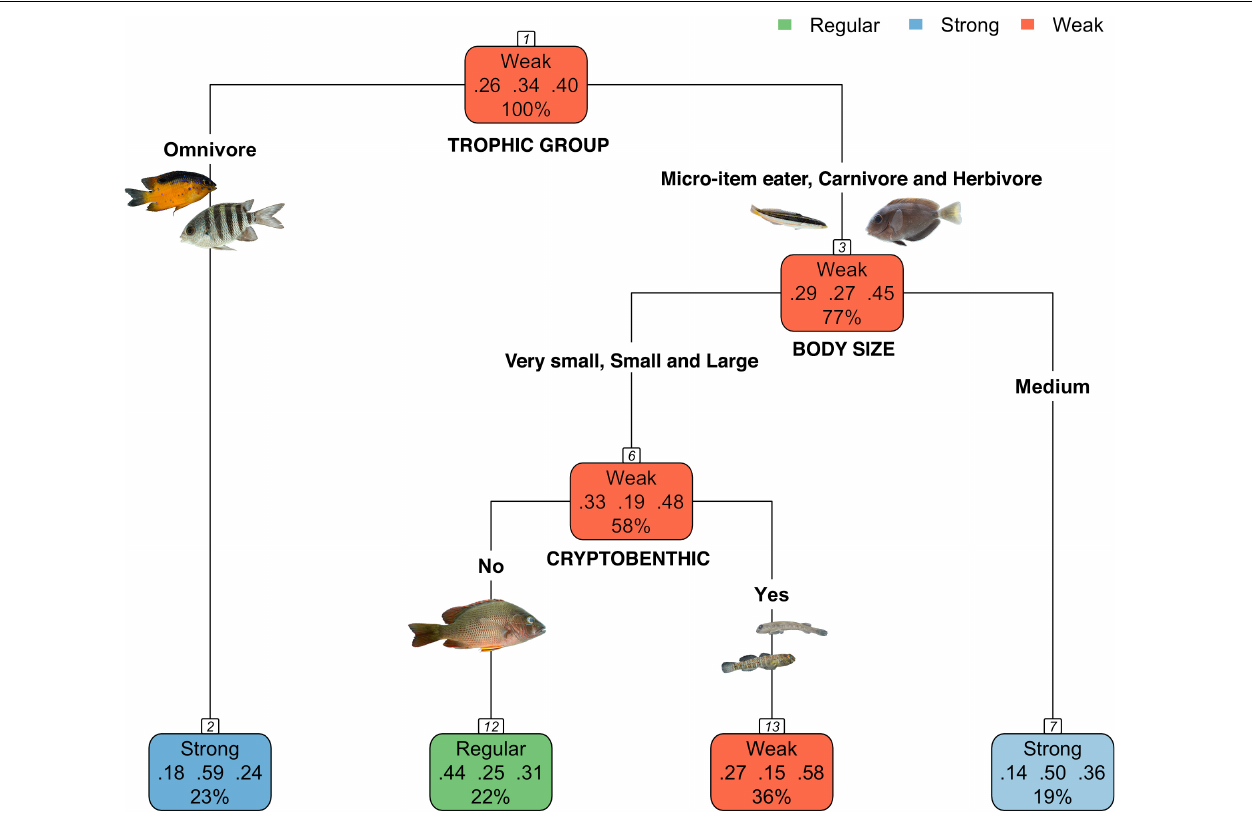
FIGURE 2 | The four-leaf tree predicting the traits related to interspecific competition success of fish taxa. Each node (color boxes) depicts the predicted class (regular, strong, or weak competition classes), its probabilities (from left to right: regular, strong, and weak) and the percentage of observations in the node. Error was 0.77 and cross-validation error was